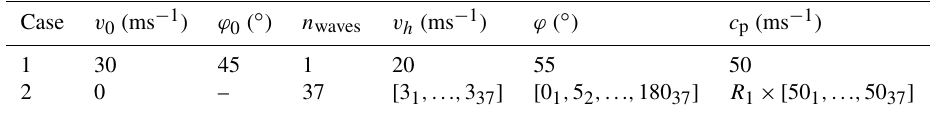
Table 2. A summary of the gravity wave parameters used in the different test wind field cases. (The subscript i on a given parameter denotes the value of the parameter for the i th wave in a specific case. R 1 refers to a random number derived from a uniform probability distribution with bounds [ 1 , 2 ] . The remaining quantities are defined in Sect. 3.1.1.)